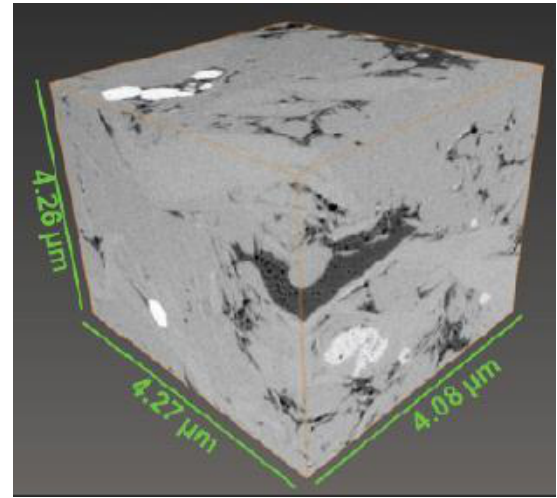
Figure 2—A 3D shale reservoir model reconstructed by